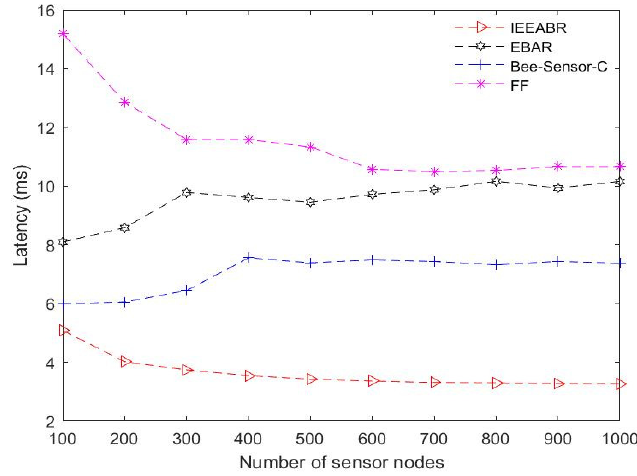
Figure 19. Comparison based on latency.